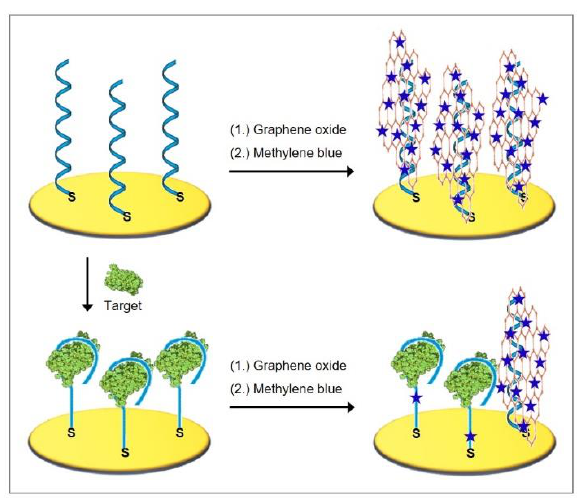
Figure 16. Schematic representation of signal amplification via graphene oxide nanosheets, investigated by Peng et al. [110].